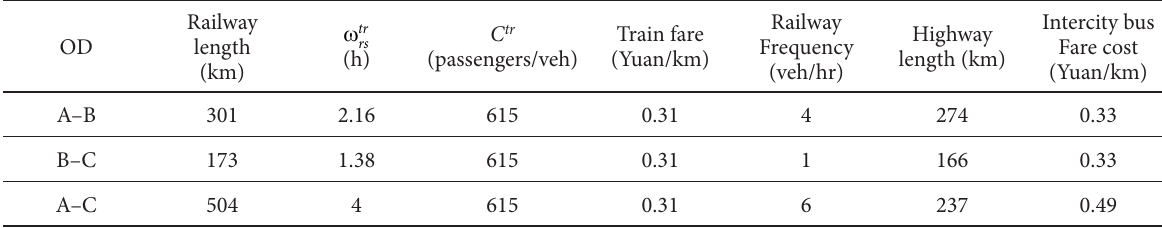
Table 2. Parameters of trains a nd intercity buses